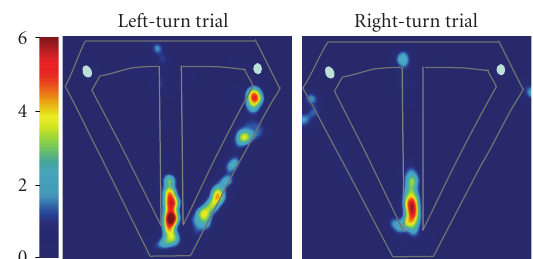
Figure 3: Location related firing of a medial entorhinal neuron that did not fire di ff erentially on left- versus right-turn trials. Significant main e ff ect of segment ( F 6,238 = 44 . 43; P < . 00001); loglikelihood ratio = 2.5; p correct = 0 . 72; p chance = 0 . 006. Color bars indicate firing rate in Hz.